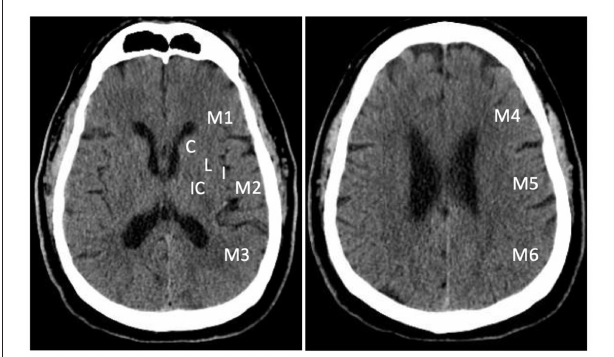
FIGURE 1 | Alberta Stroke Program Early Computed Tomography Score (ASPECTS). The scoring system divides the MCA territory into 10 zones at ganglionic and supra-ganglionic levels: 6 for cortical regions (M1- M6), and 4 subcortical regions (C, caudate; L, lentiform; IC, internal capsule; and I, insular